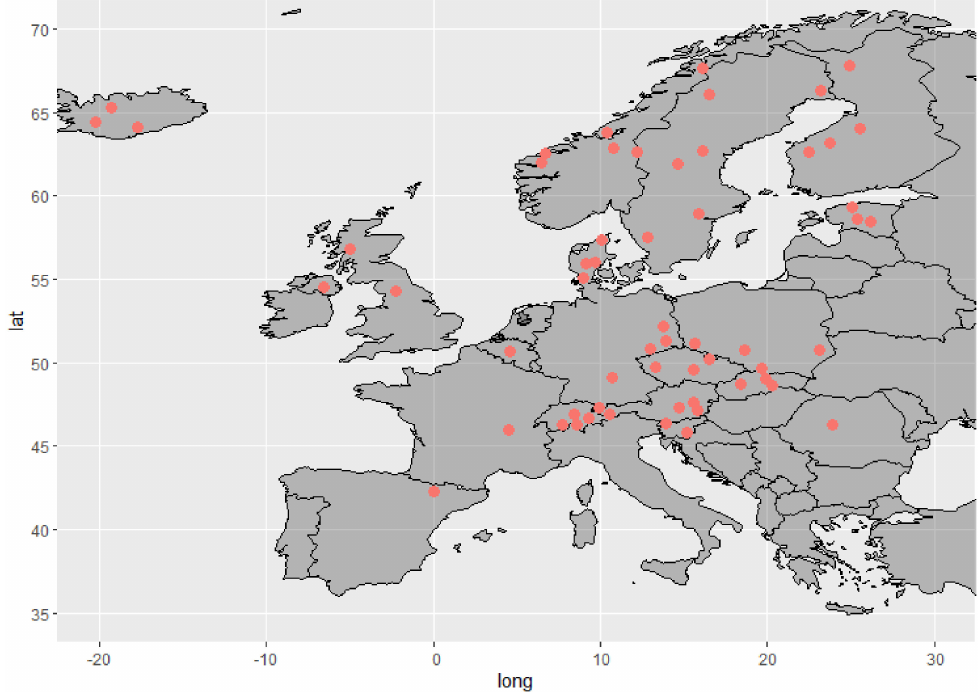
Figure 2. Gauging stations locations for catchments that were selected in Europe. Daily discharge data for the selected catchments were obtained from the Global Runoff Data Centre [18]. Daily mean discharge from 1979 to 2019 was used in the study. Additionally, the catchment boundaries were also obtained from the GRDC [18]. Figure 3 shows an example of the daily discharge time series for the Penobscot River catchment in the USA, which was one of the selected catchments in North